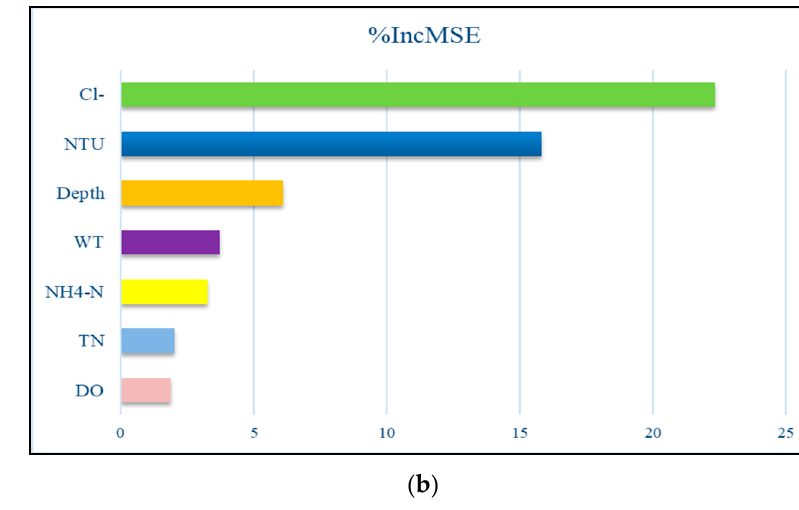
Figure 7. Effects of five environmental drivers (NTU, WT, COD cr , TN, and DO) on phytoplankton in spring.